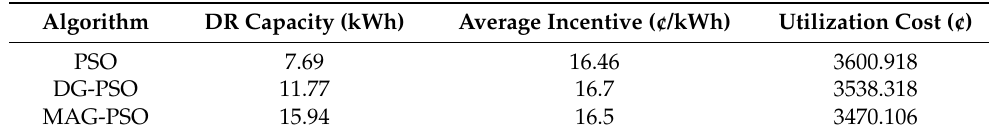
Table 6. Comparison of